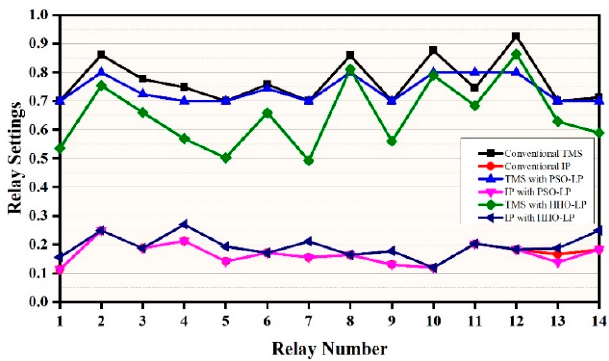
Figure 13. Relay settings for the IEEE-8 bus system. Figure 12. Primary and backup relay pair characteristics for relay pair 6 ( a ) with conventional settings, and ( b ) with settings updated using the proposed algorithm.